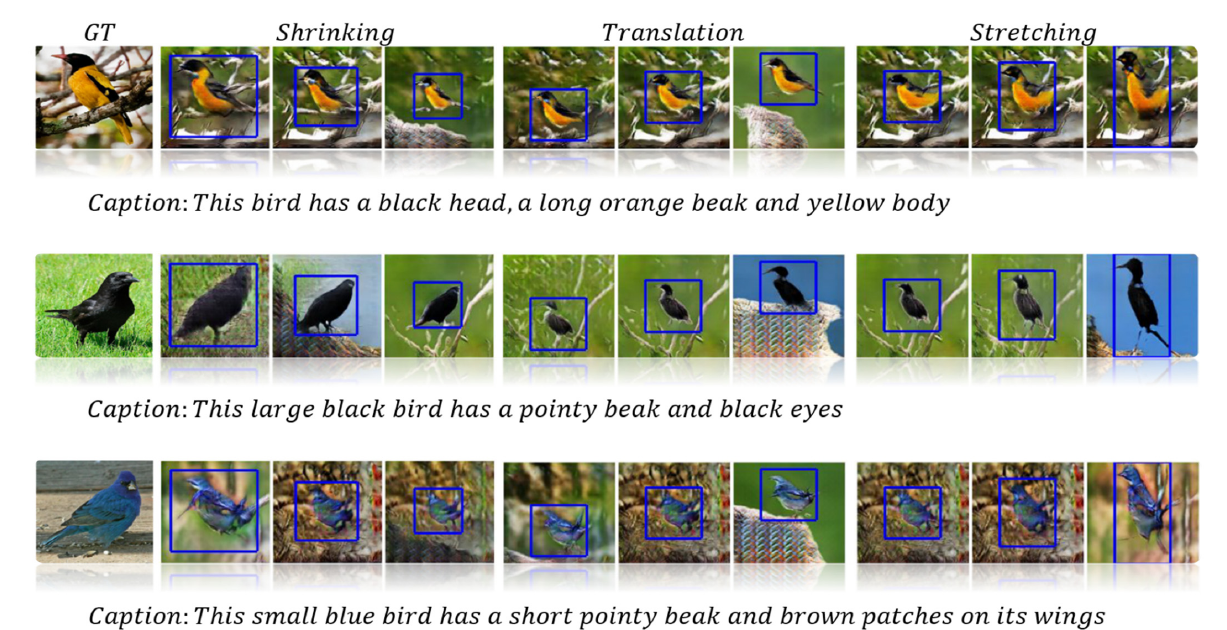
Figure 19. Controlling the bird’s position using bounding box coordinates and previously unseen text [70].